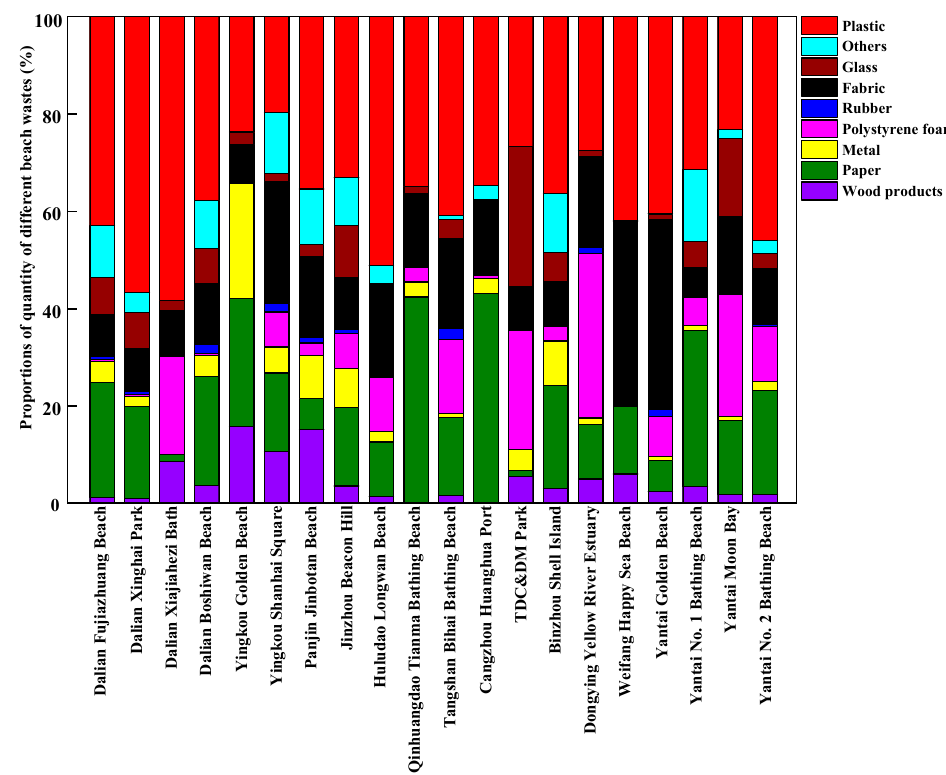
Figure 3. The proportions of different components of beach waste in coastal cities around the Bohai Sea of China in the tourist off-peak season, by quantity.